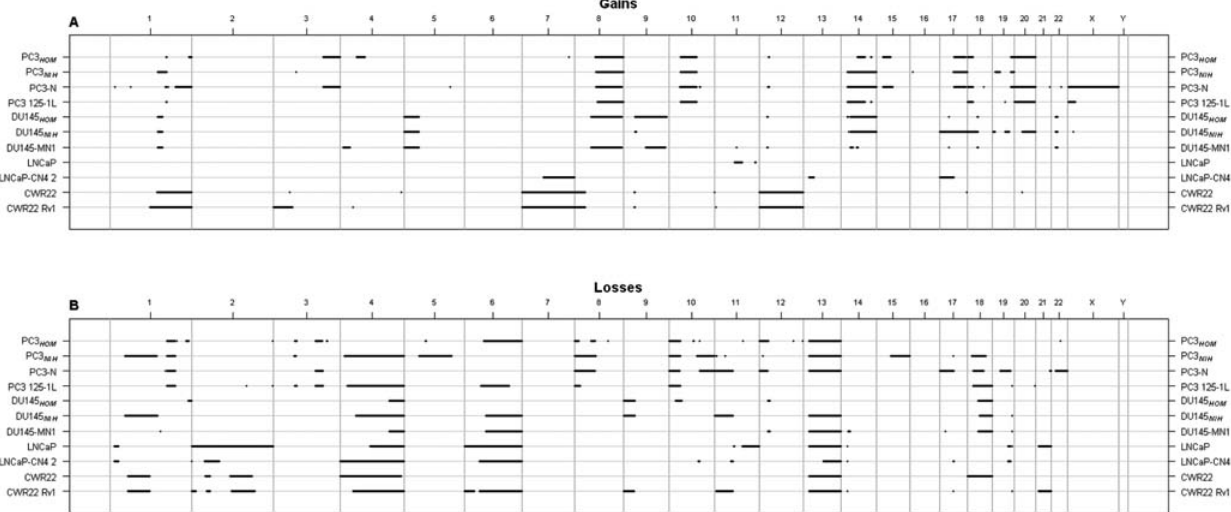
Figure 2. Whole genome plot of gained (A) and lost (B) chromosomal regions of 11 prostate cancer cell lines, as detected with aCGH. Numbers above the plot indicate chromosome numbers and vertical lines boundaries between chromosomes.